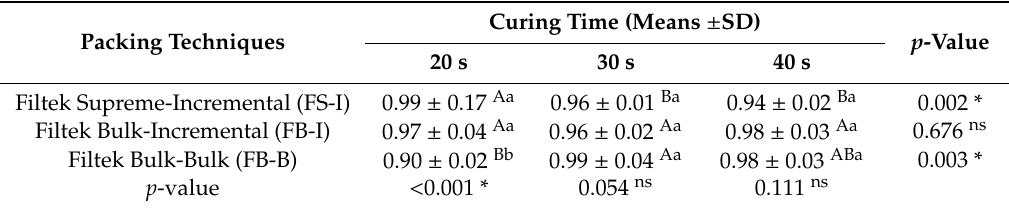
Table 2. Mean ± standard deviation (SD) values of the bottom / top ratios’ Vickers hardness numbers (depth of cure) for di ff erent curing times and packing